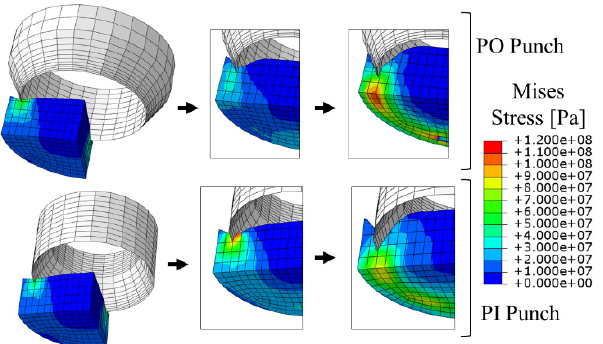
Figure 20. Phases of cutting in CEL FEM analyses for both PI and PO punches and belt TFL10S.